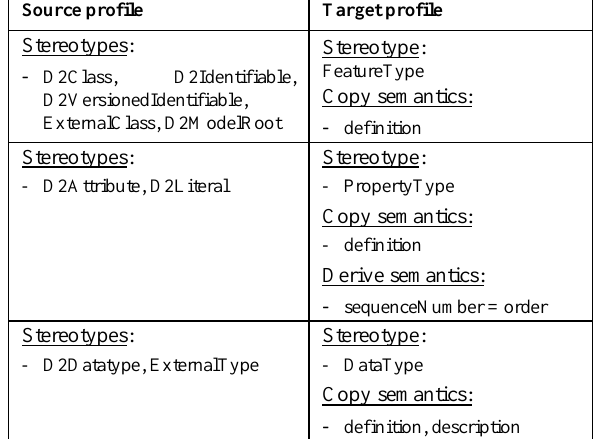
Table 1. Examples of rules for mapping from DATEX II to the CGP and the GML Encoding Profile.